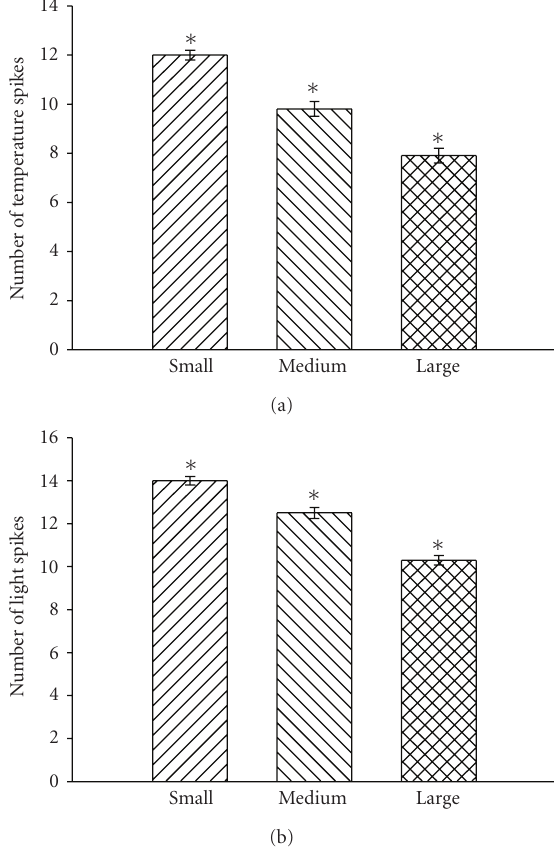
Figure 2: (a) Mean number of temperature spikes (abrupt 0 . 5 ◦ C changes) monitored by an OnSet temperature logger attached 4cm above the skin of small ( n = 6), medium ( n = 6), and large ( n = 6) dragons. (b) Mean number of light spikes (abrupt 0.1log Lum/m 2 changes) monitored by a light intensity logger attached 4cm above the skin of small, medium, and large dragons. Vertical line represents ± SEM. Asterisk depicts a significant di ff erence between means at the P < . 05